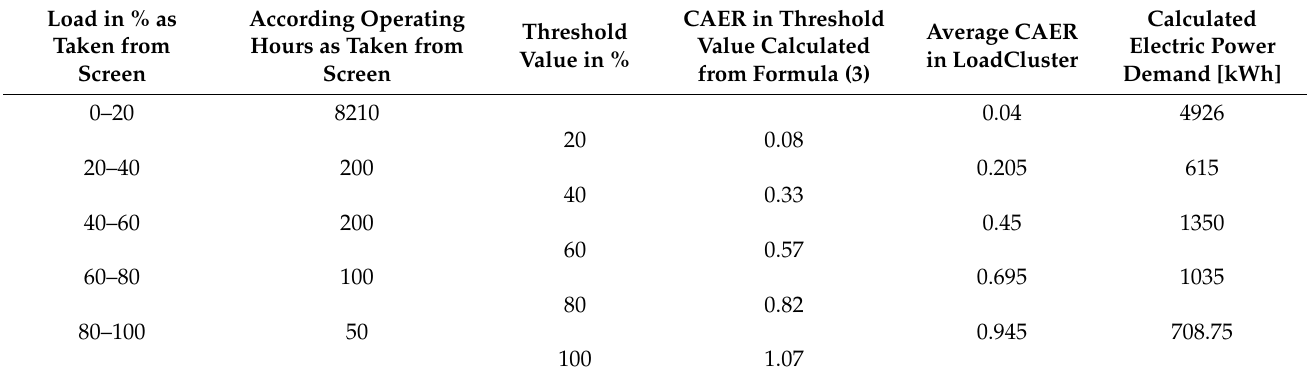
Table 4. Calculation example for VFD compressors (source: own representation). Load in % as Taken